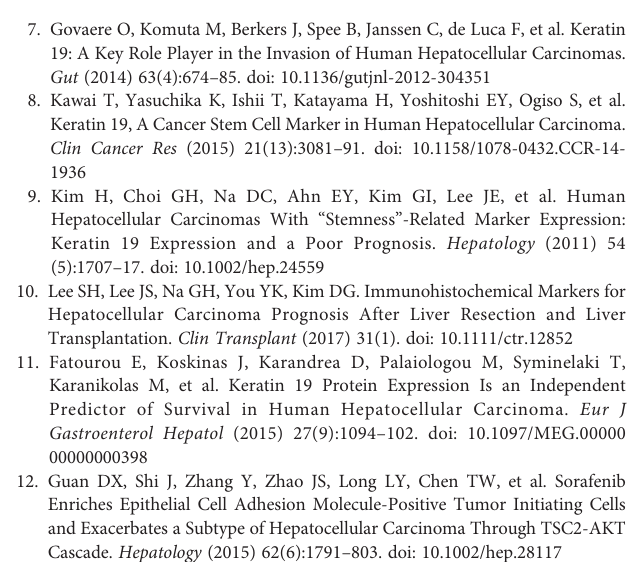
Supplementary Figure 2 | The mRMR algorithm importance ranking of top 15